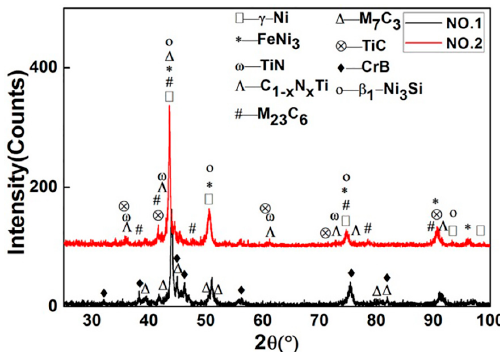
Figure 2. XRD patterns of No.1 and No.2 specimen coatings (0.0 < x < 1.0).